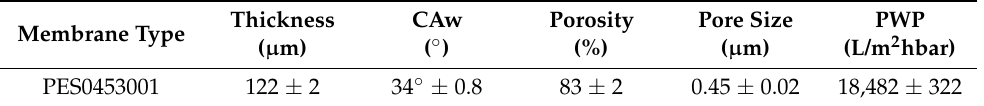
Table 3. Commercial PES membrane properties.